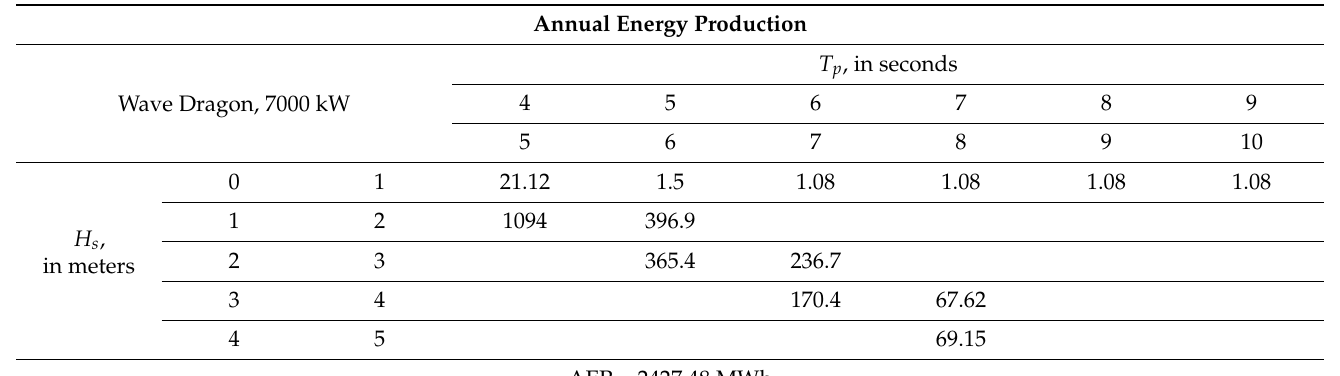
Table 8. Sample computation of AEP for Wave Dragon (7000 kW) at Station